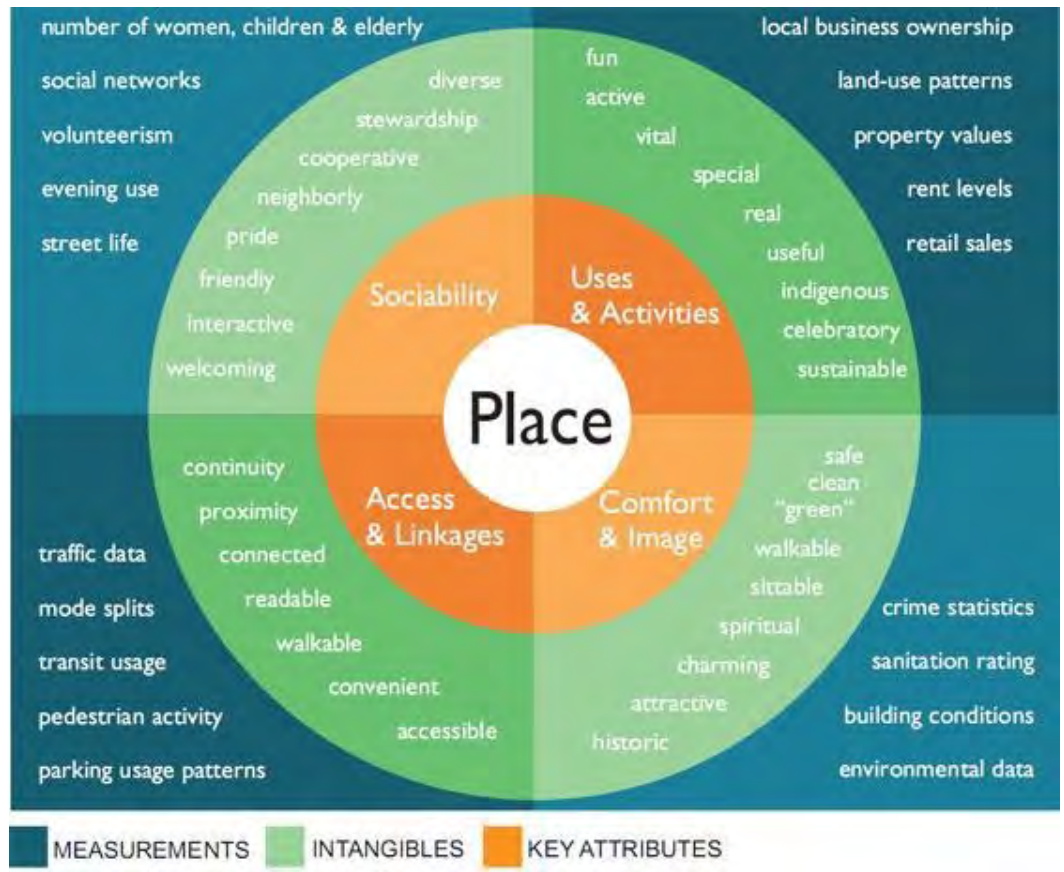
Figure 2. Shows Place Making Elements Source: